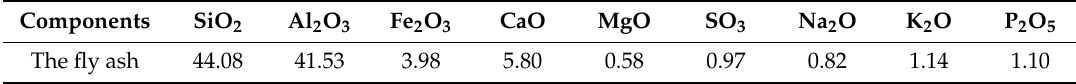
Table 4. Chemical analysis of fly ash